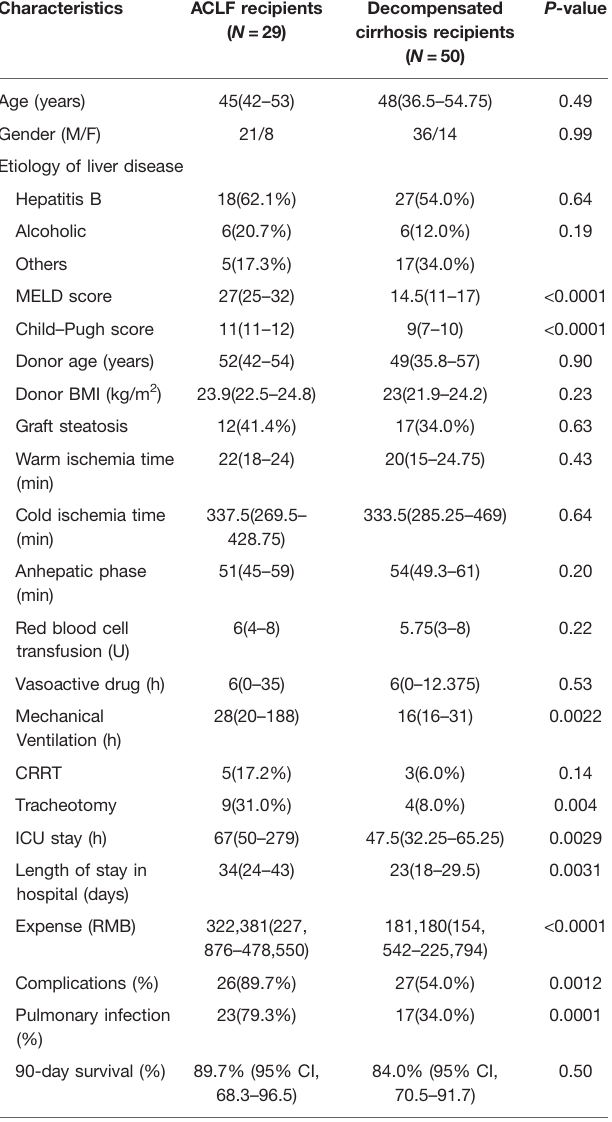
TABLE 2 | Main characteristics of ACLF and decompensated cirrhosis recipients. Characteristics